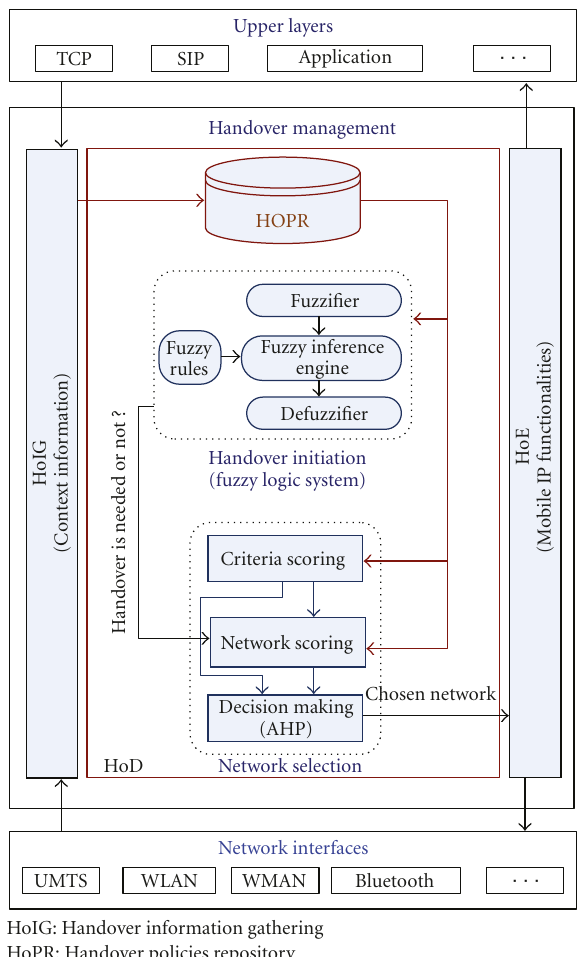
Figure 1: Our handover management system